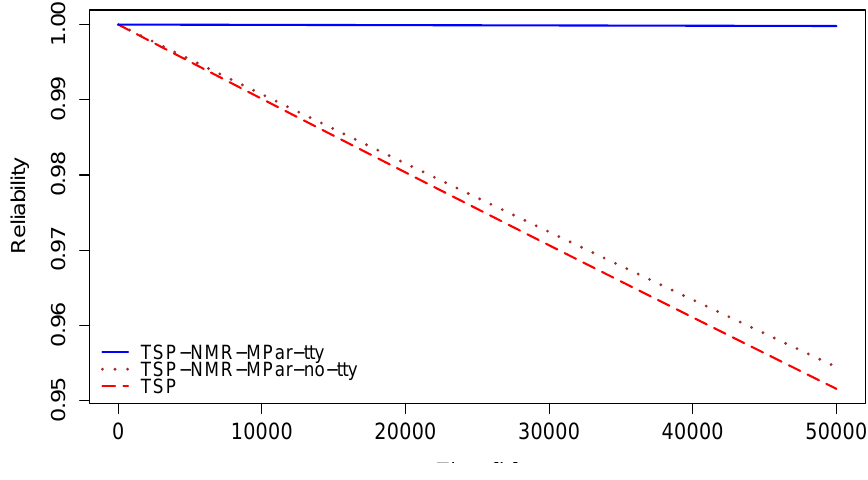
Figure 5. Evaluation of reliability for Matrix Multiplication application at 35,000 ft.